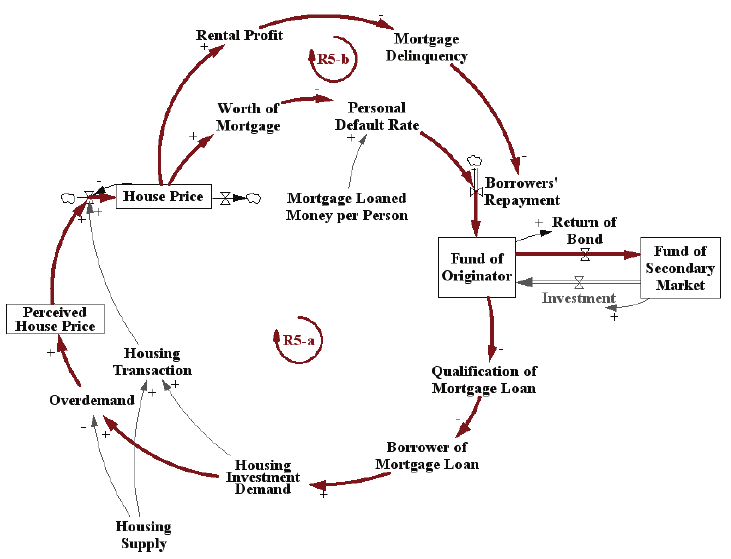
figure 9. relationship between house price and mortgage